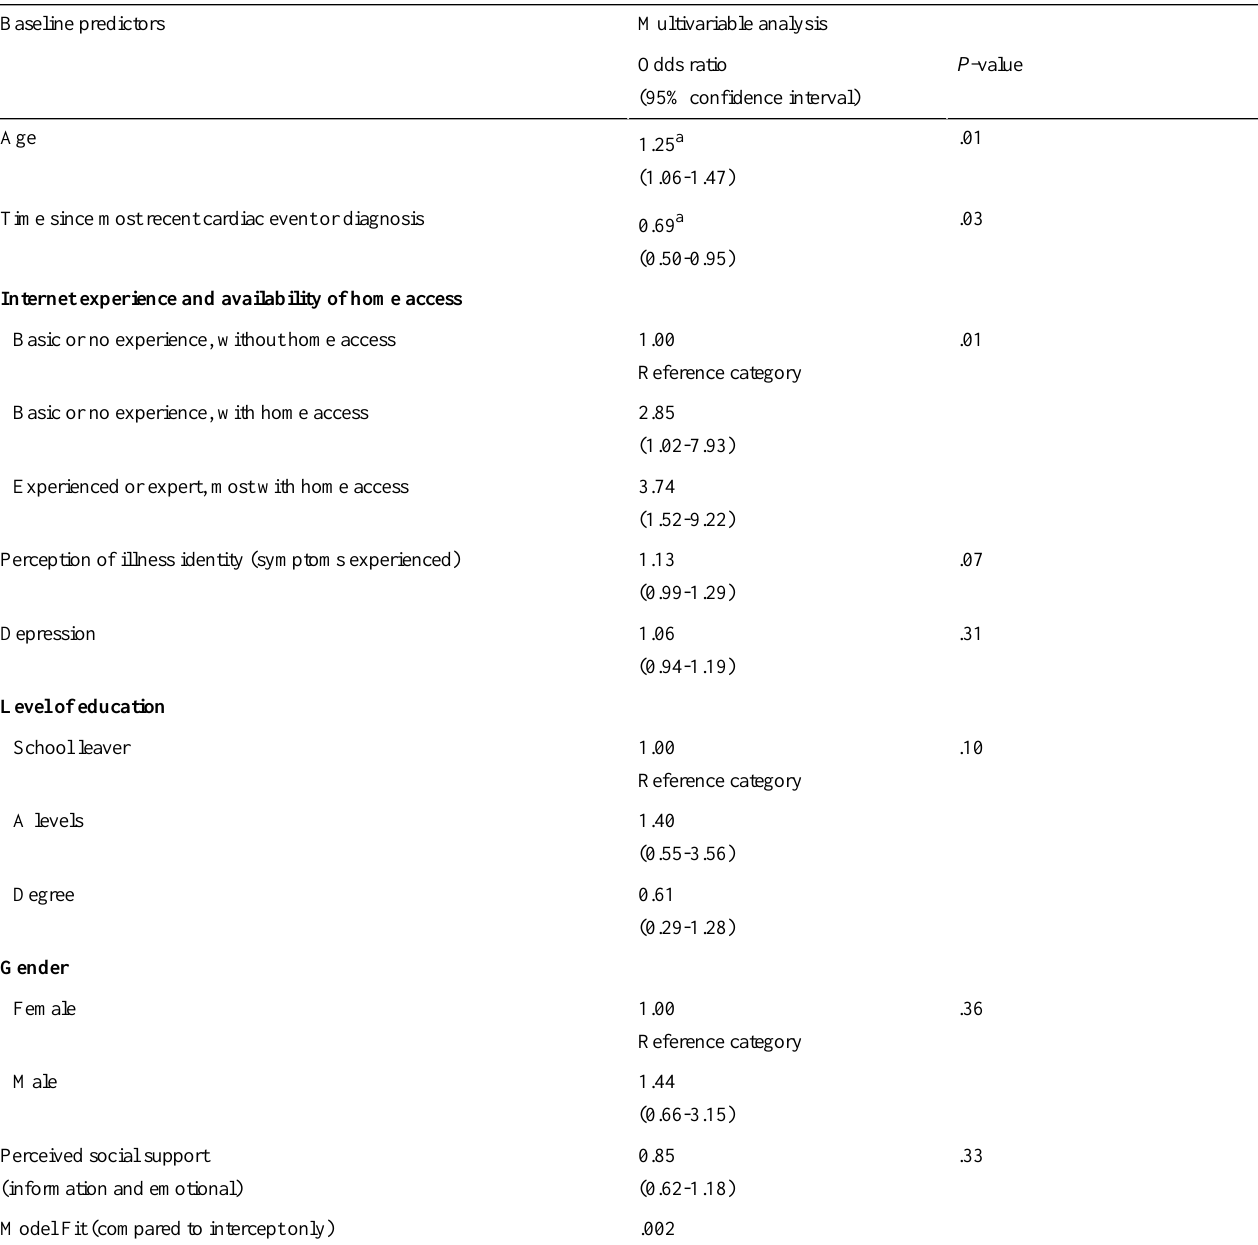
Table 3. Results of ordinal regression analyses predicting overall level of intervention use (no use, low use or high